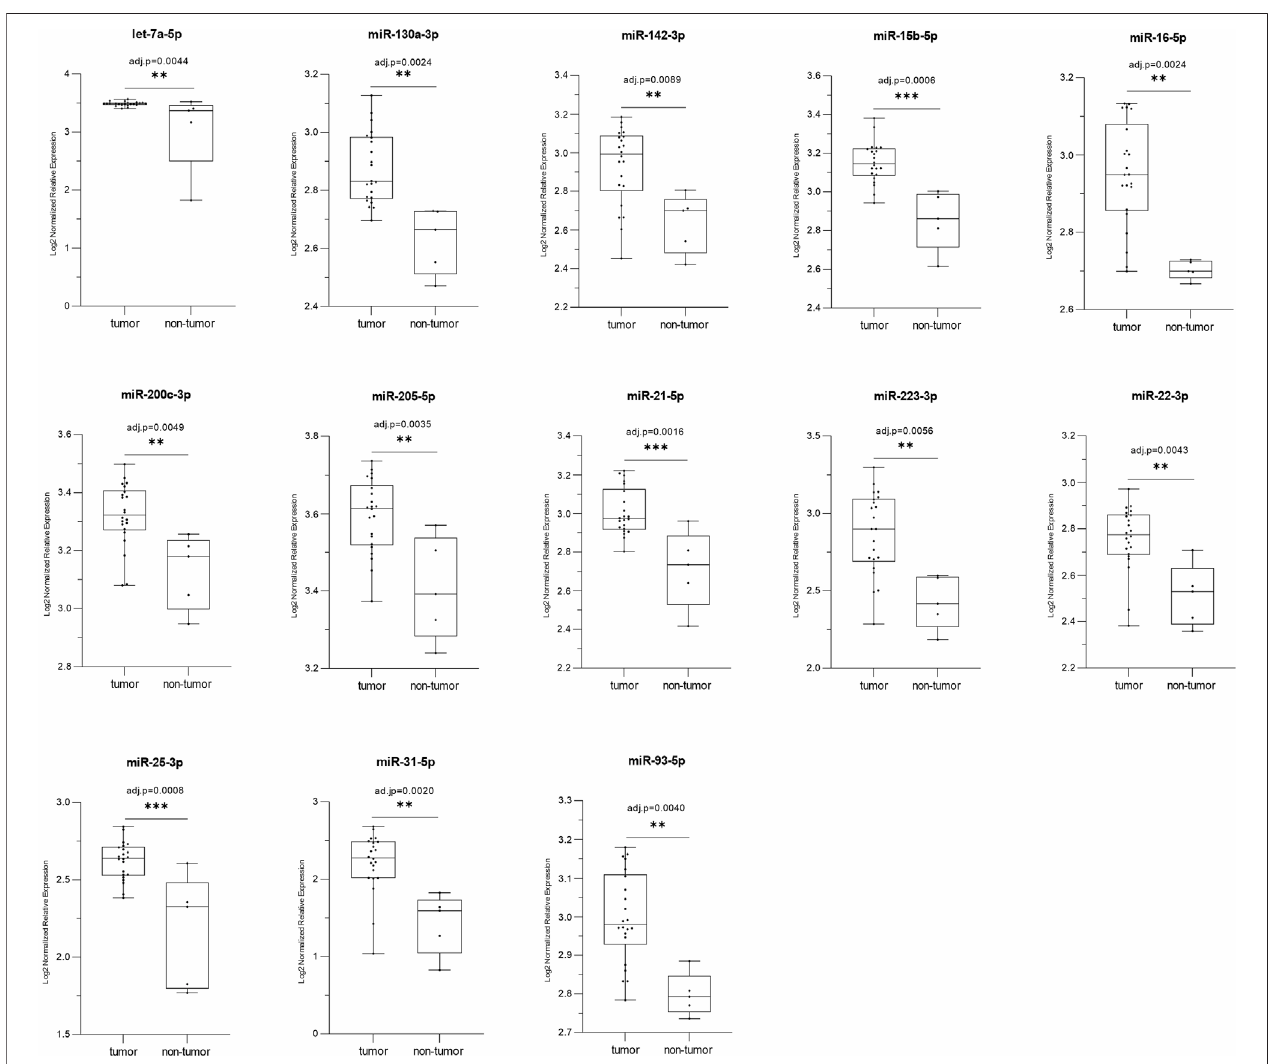
FIGURE1| Thebox-plots represent acomparison oftherelative expression levels ofthe13miRDEupregulatedin tumors ( n =22)versusnormal tissue ( n =5); p ≤ 0.05 by t -test and adj.-p ≤ 0.01 by Benjamini – Hochberg; * p ≤ 0.05, ** p ≤ 0.01 and *** p ≤ 0.001.